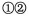
The underlying mechanism by which DHA improves autophagic flux and clears Aβ40 and Aβ42.  APP, Aβ40 and Aβ42 can reach the early endosome either via the trans-Golgi network (TGN) or via the cell surface.  In parallel, normal autophagy is induced by the formation of APs that initiate at the phagophore assembly site; nucleation of the phagophore, sequestration of substrates, and expansion of the double membrane are involved in this process, which is markedly hindered in AD pathology. To reverse this process, DHA upregulated the levels of the Atg5-Atg12-Atg16L complex to facilitate LC3 lipidation (LC3 I) with phosphatidylethanolamine that was inhibited by AD-like pathogenesis . In addition, the treatment of DHA protected against the bafilomycin A1-induced abnormal fusion of APs and late endosomes, ameliorated the CQ-mediated loss of lysosomal degradation function, and finally promoted the degradation of Aβ40 and Aβ42.